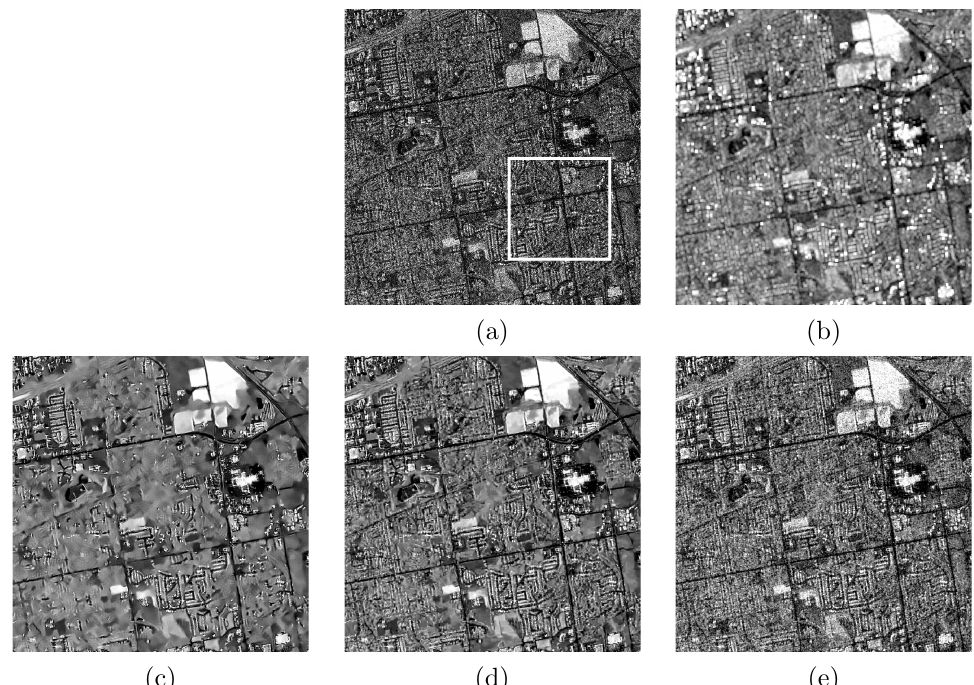
Figure 17. Chicago test case: ( a ) noisy SAR data and restored images obtained using: ( b ) Kuan, ( c ) PPB-it, ( d ) FANS, and ( e ) EWF.